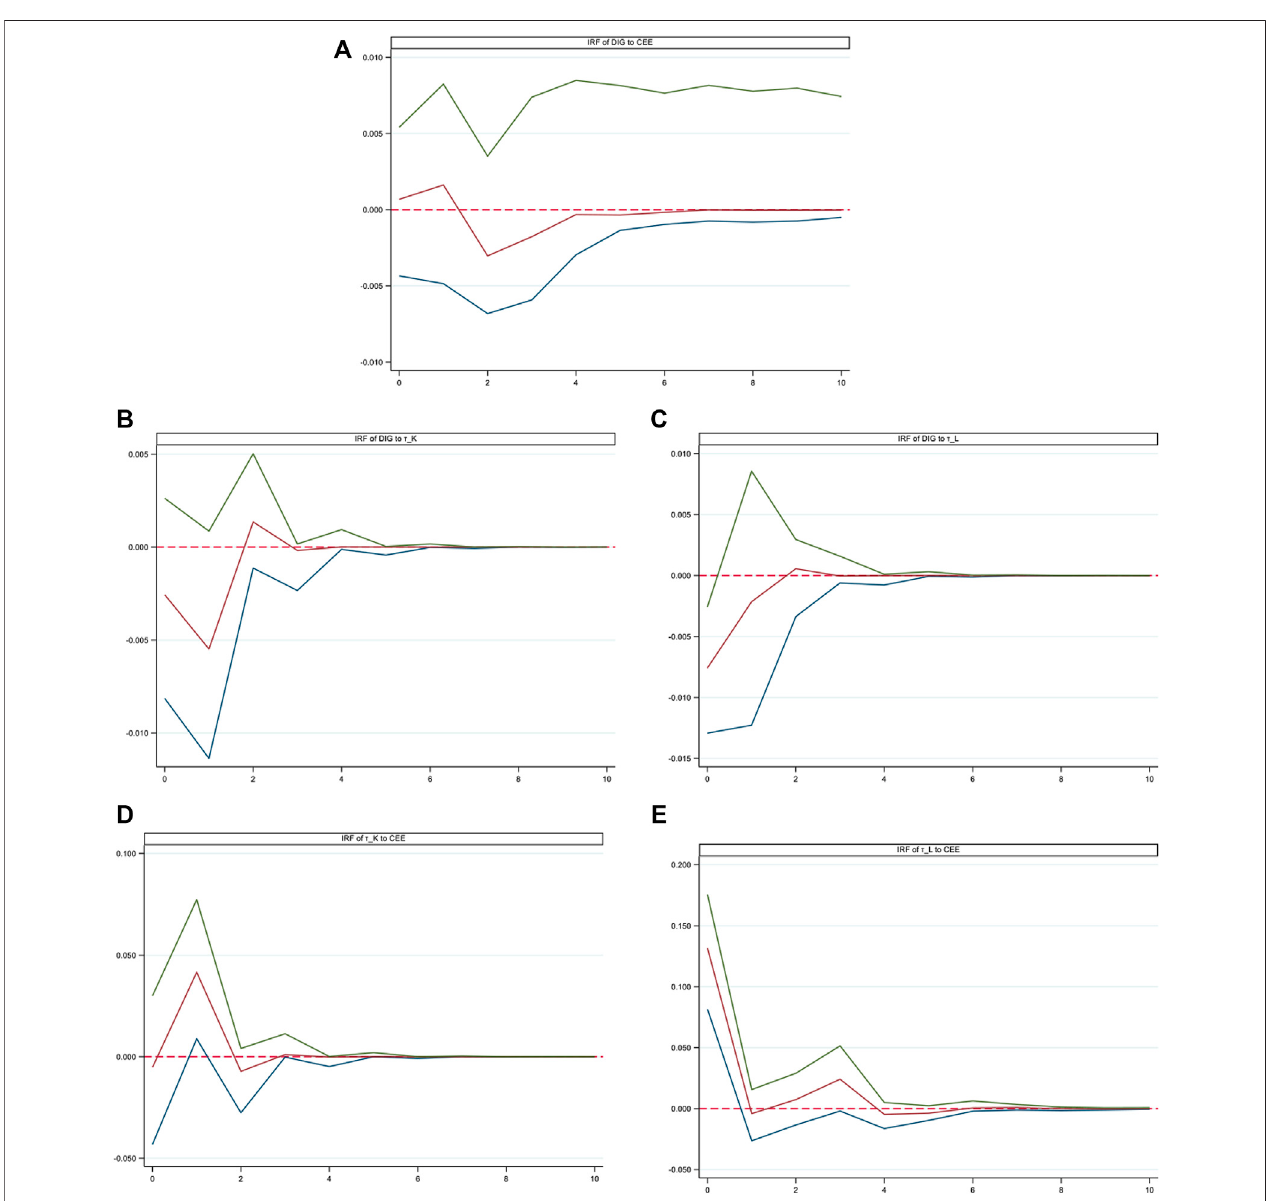
FIGURE 2 | Impulse response function